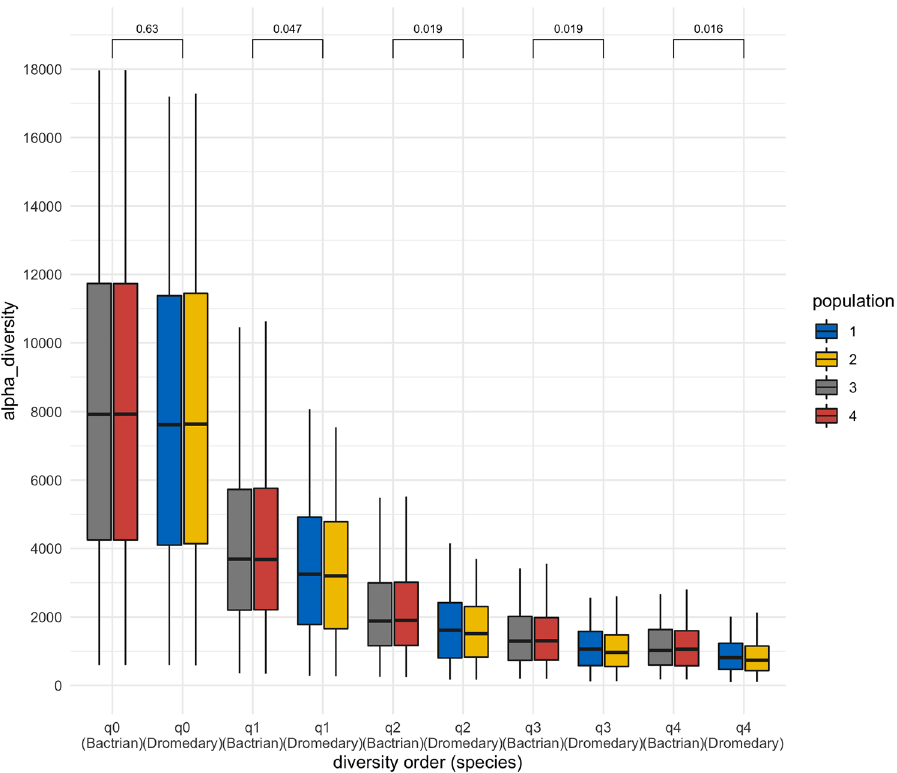
Figure 3. Mean autosomal alpha diversity at the diversity orders q = 0 to 4. Populations: (1) Arabian Peninsula dromedary camels; (2) dromedary camels from Iran; (3) Bactrian camels from Iran; and (4) Bactrian camels from Kazakhstan. Mann–Whitney U test P -values for pairwise comparisons of dromedary (1 and 2) against Bactrian (3 and 4) are reported.